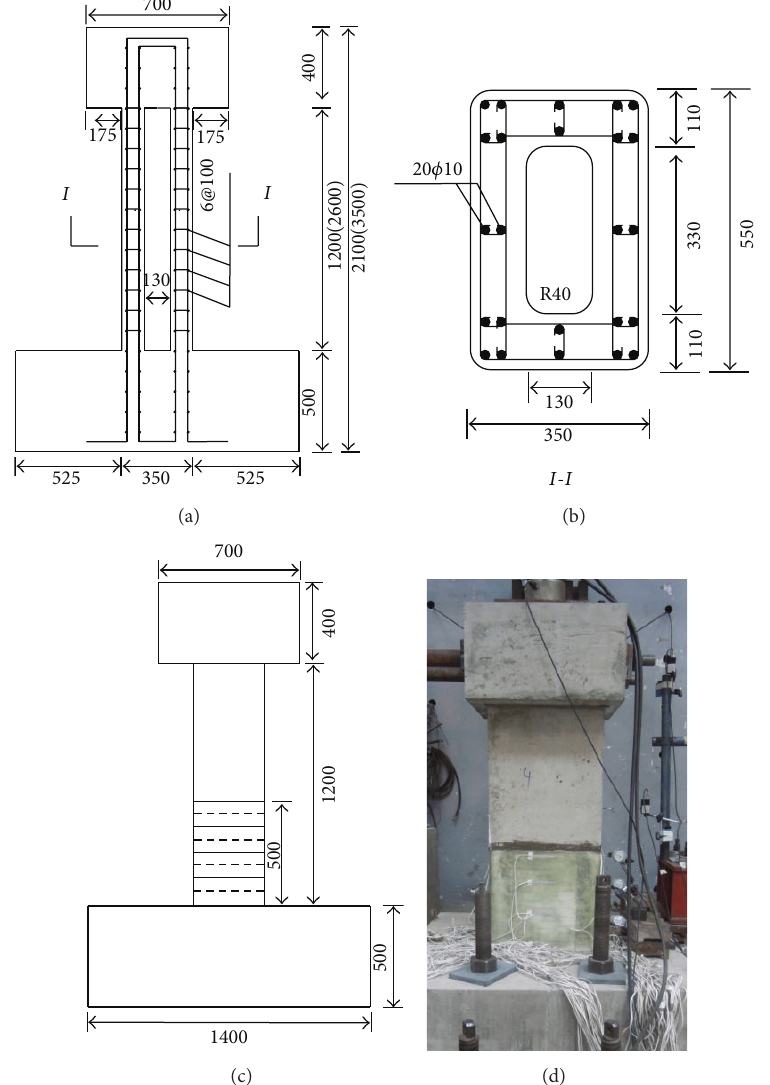
Figure 1: Column specimen (unit: mm), (a) dimensions of specimen, (b) configurations of lateral steel (c) 𝐿/𝑏 = 8 , and (d) specimen photo.